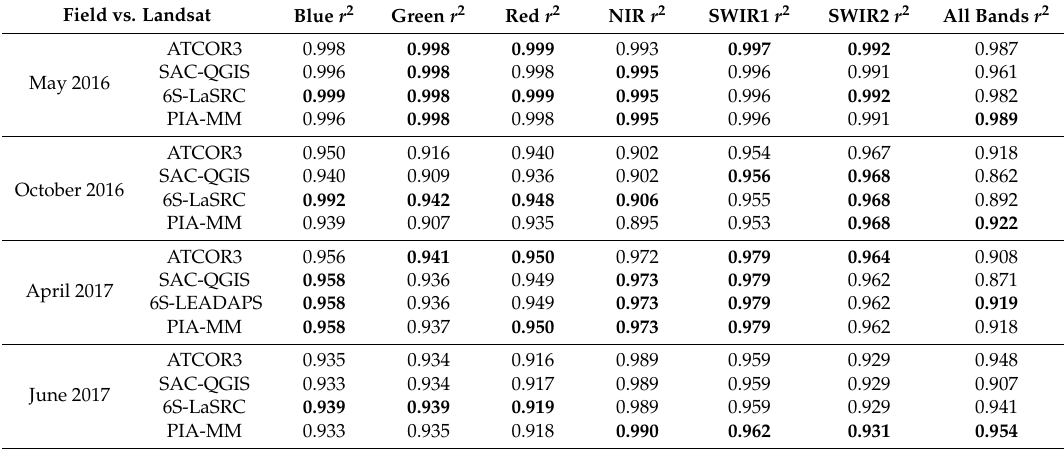
Table 3. Band-by-band coefficient of determination ( r 2 ) between field spectroradiometry values and atmospheric corrections for Landsat-7 (ETM+) and Landsat-8 (OLI) imagery. Best values in